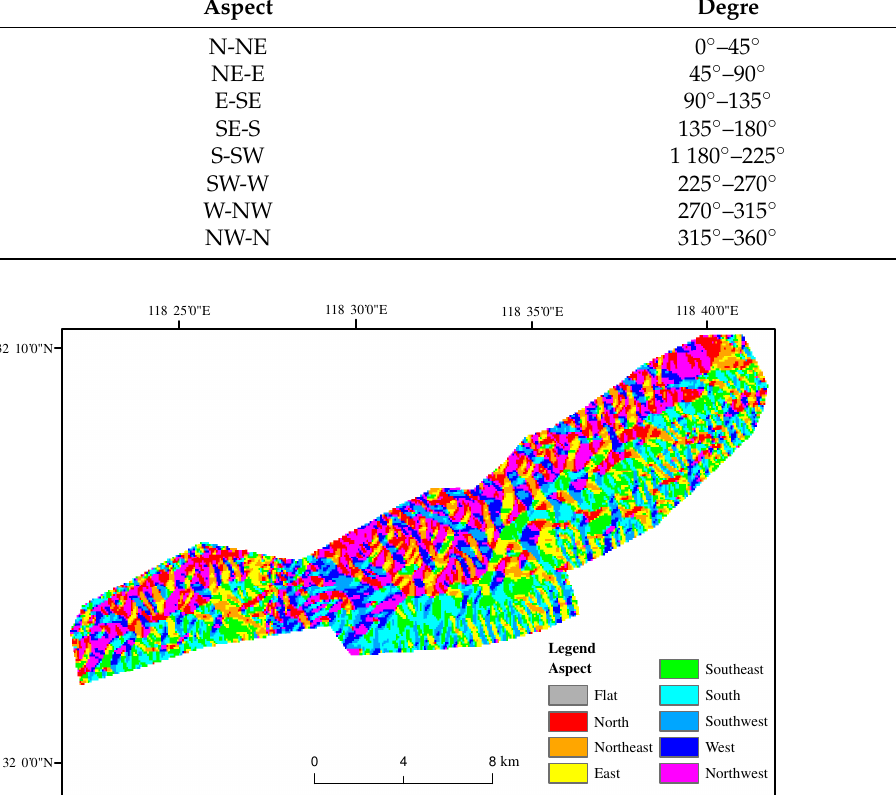
Figure 5. The base map of aspect in Laoshan. Each level is determined by the fire risk